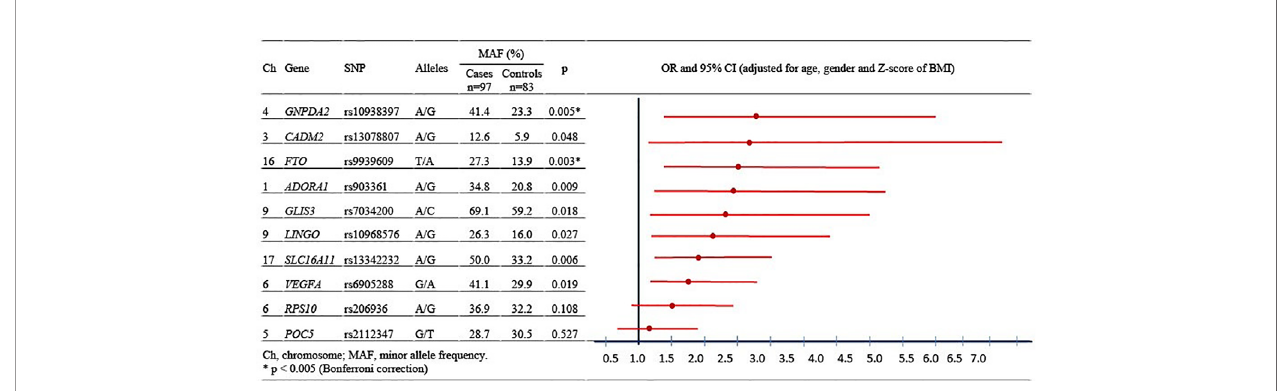
FIGURE 1 | Allele frequency and association between individually single nucleotide polymorphisms and pediatric-onset type 2